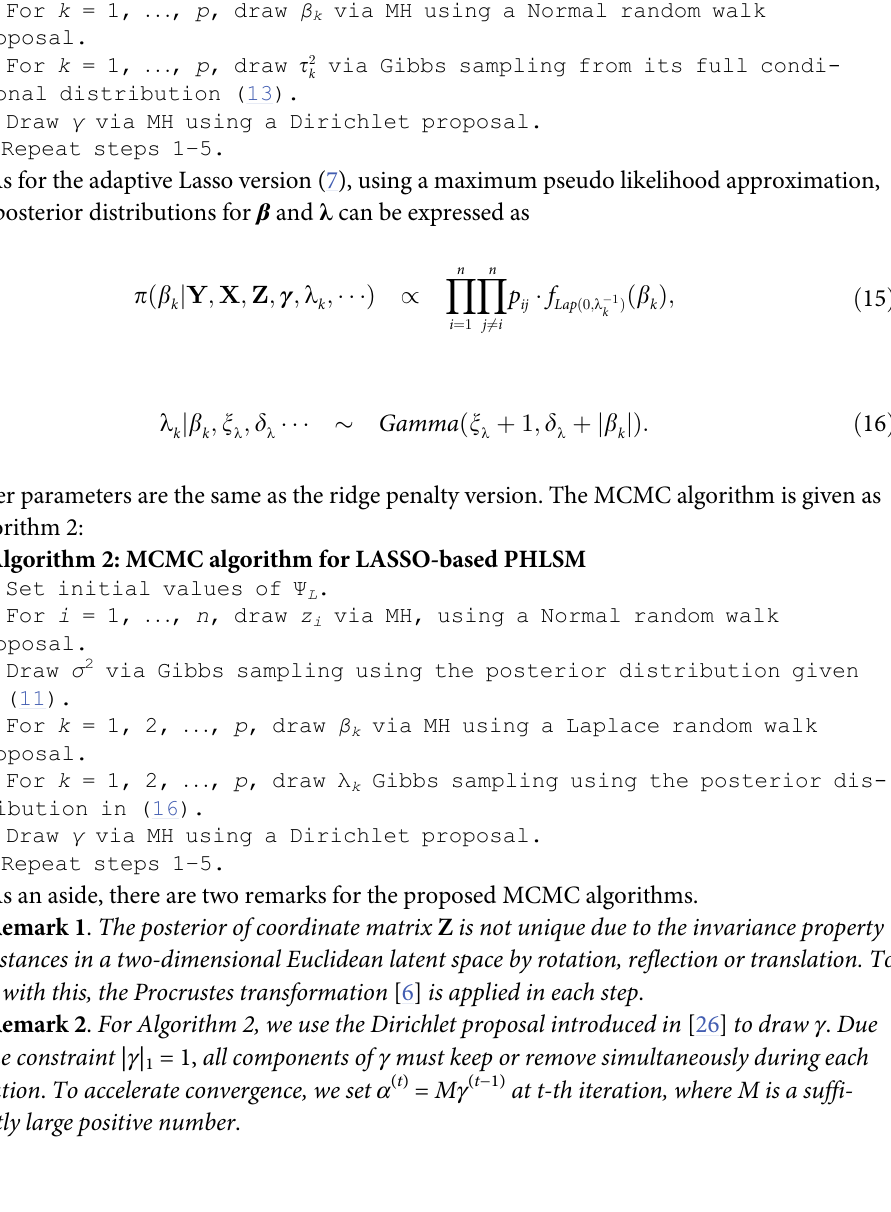
Algorithm 1: MCMC algorithm for PHLSM